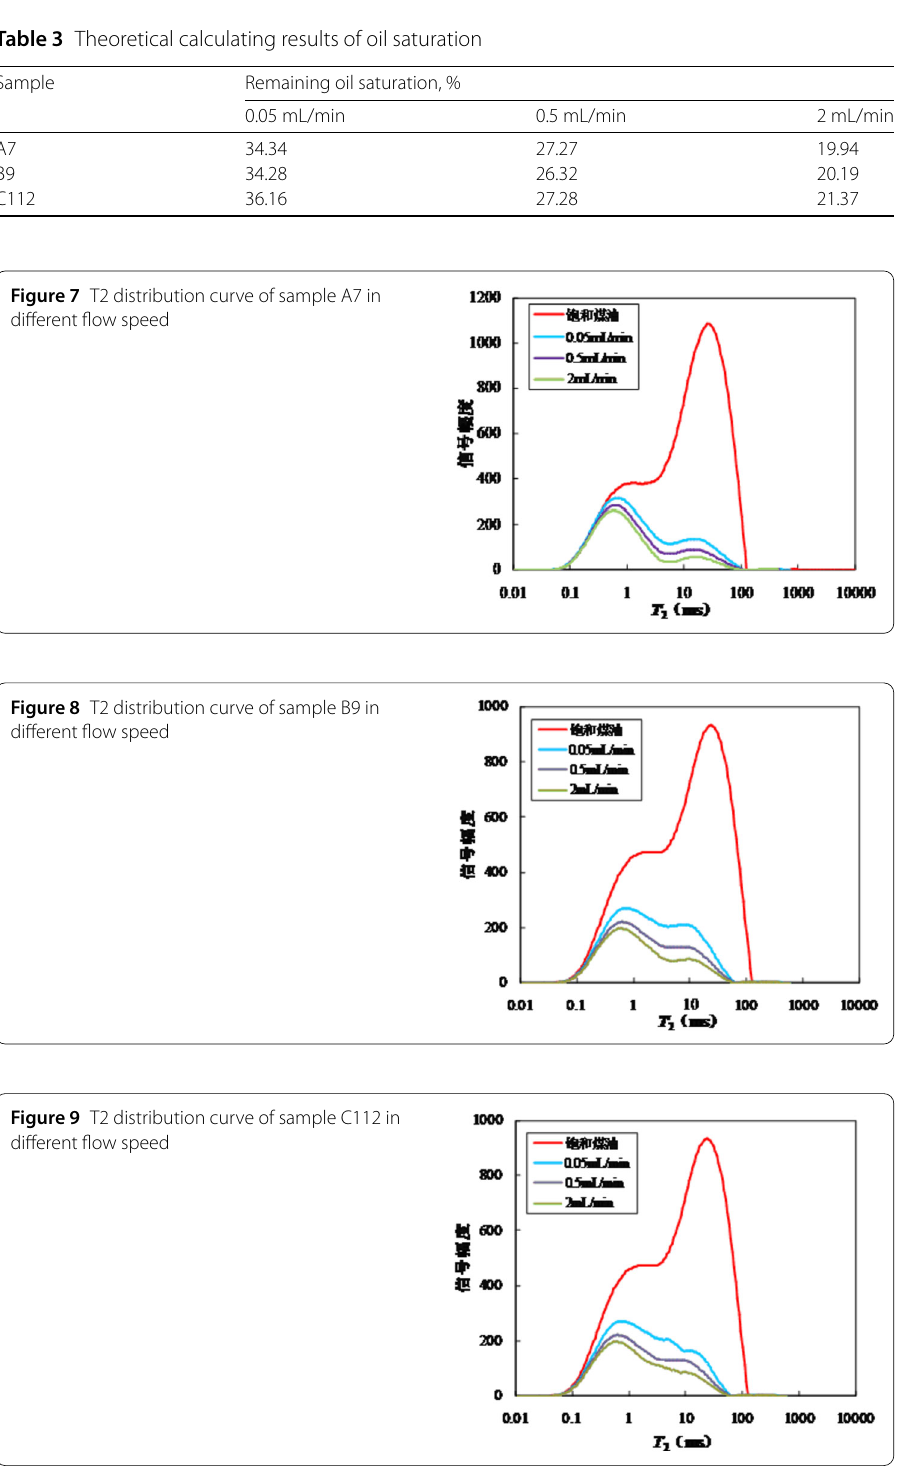
Table 3 Theoretical calculating results of oil saturation